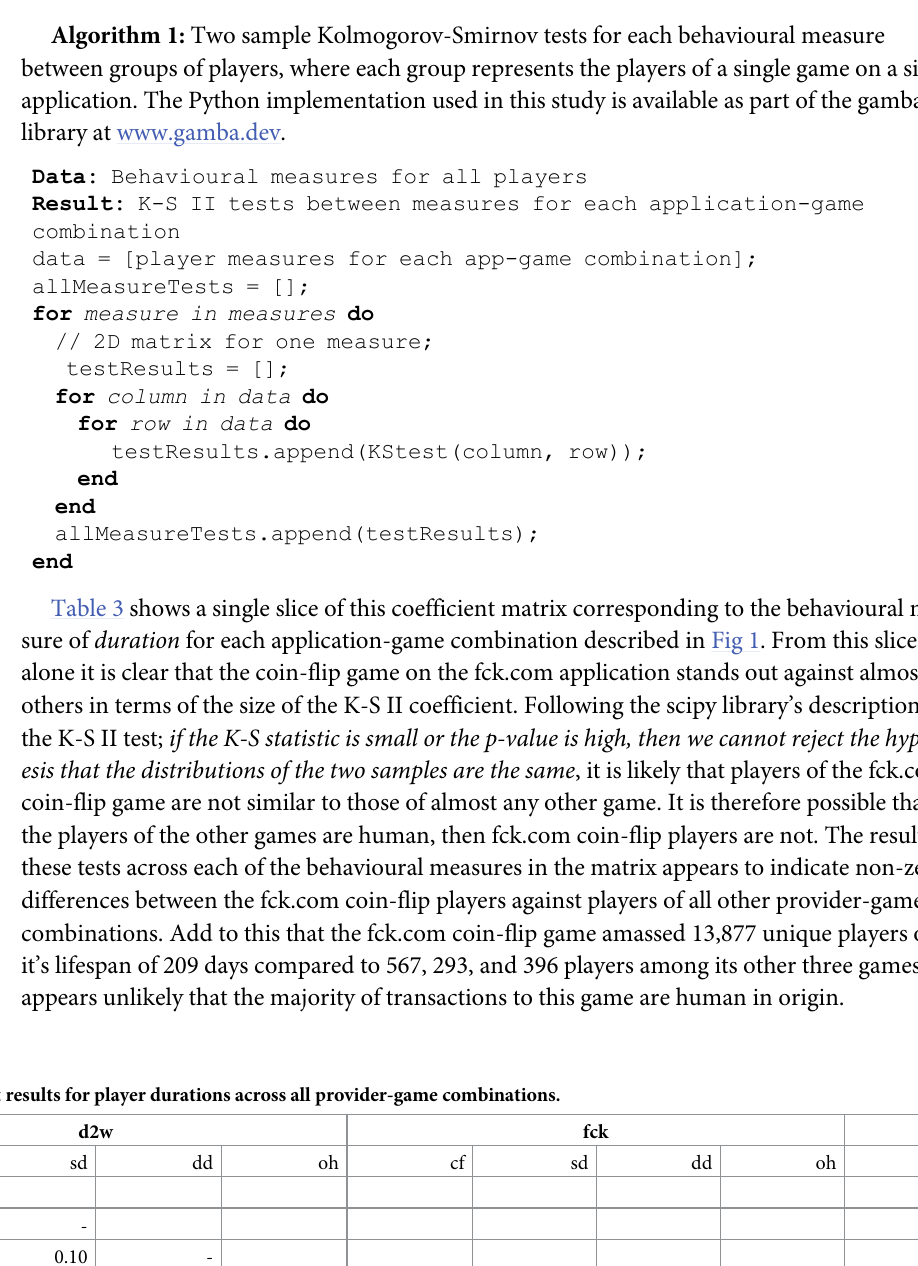
Table 3. Two sample Kolmogorov-Smirnov test results for player durations across all provider-game combinations. Provider d2w fck eroll